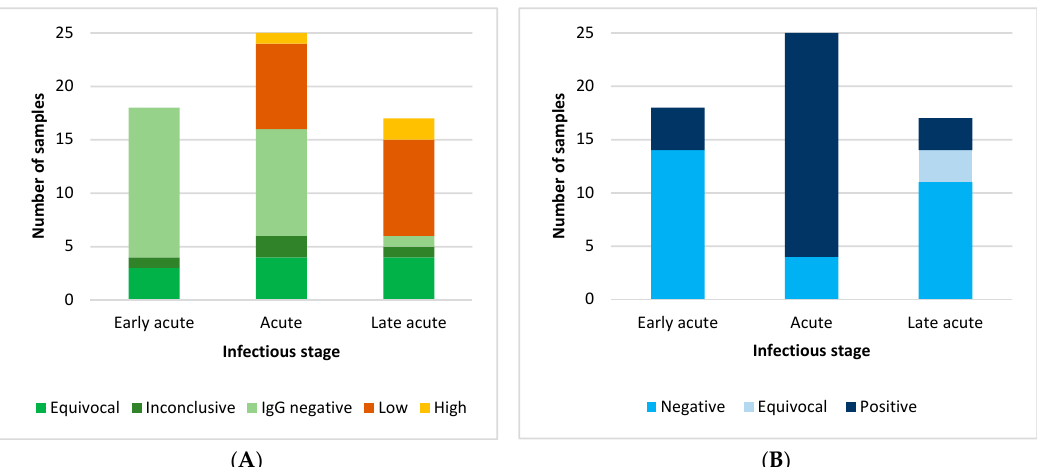
Figure 1. Serological testing in patients from groups I and II. ( A ) ZIKV IgG avidity results; ( B ) ZIKV IgA Results.